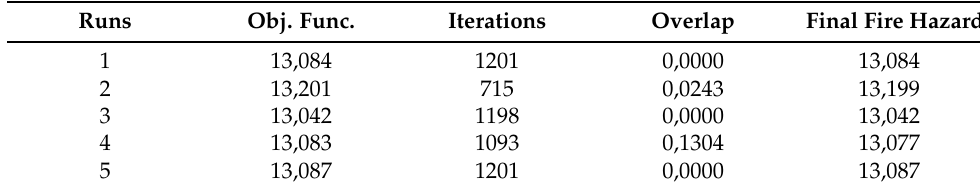
Table 2. Algorithm results for region 1.